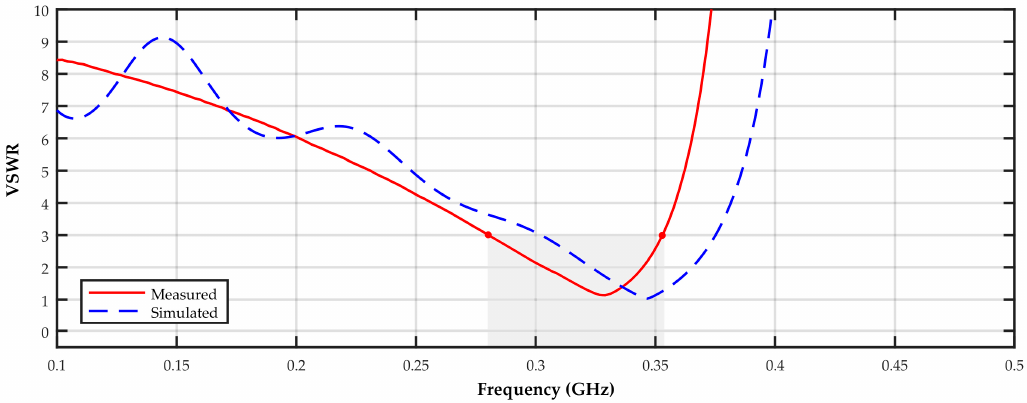
Figure 9. Simulated and measured VSWR of the prototype meandered PIFA.